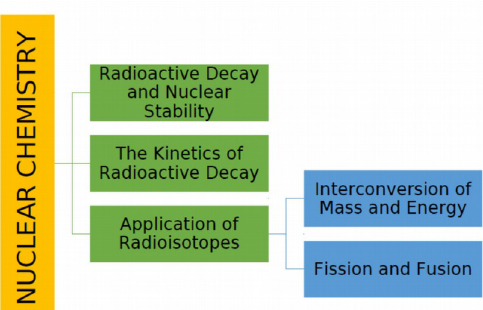
Figure 9. An example of an advance organizer in a topic (Hamid, 2020)